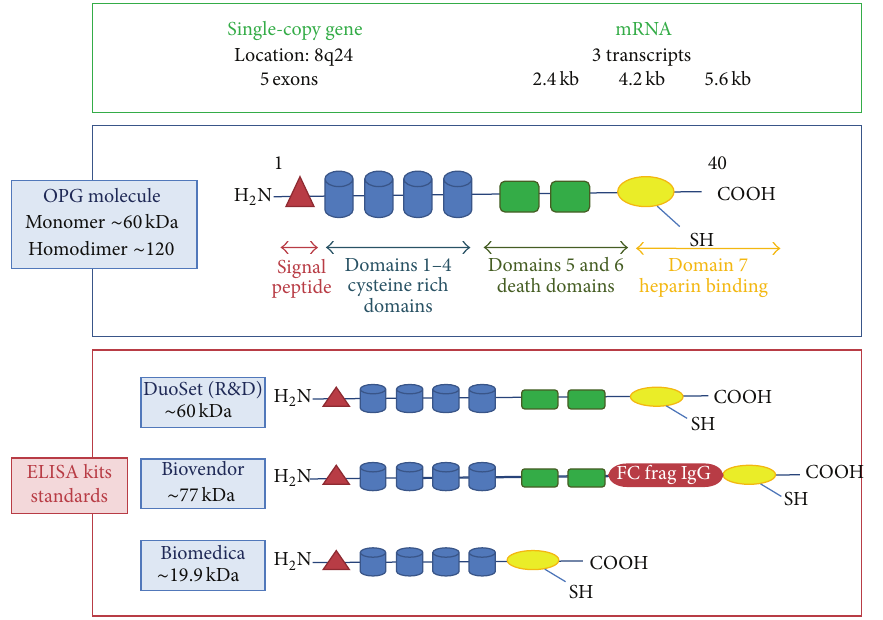
Figure 1: Osteoprotegerin structure and different ELISA kit